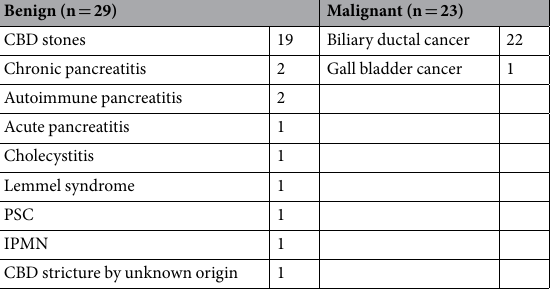
Table 6. Biliary tract diseases or origin of benign biliary stricture in targeted patients. CBD , central biliary duct; PSC , primary sclerosing cholangitis; IPMN , intraductal papillary